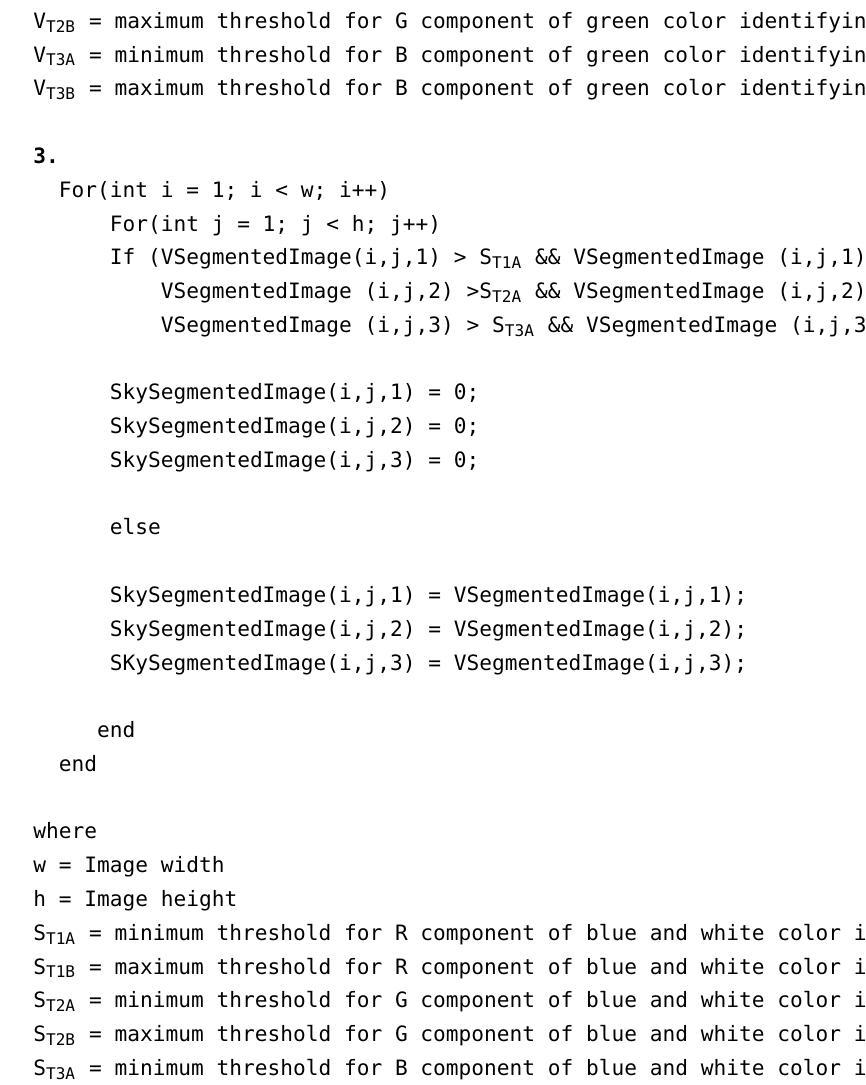
V T2A = minimum threshold for G component of green color identifying vegetation V T2B = maximum threshold for G component of green color identifying vegetation V T3A = minimum threshold for B component of green color identifying vegetation V T3B = maximum threshold for B component of green color identifying vegetation 3.